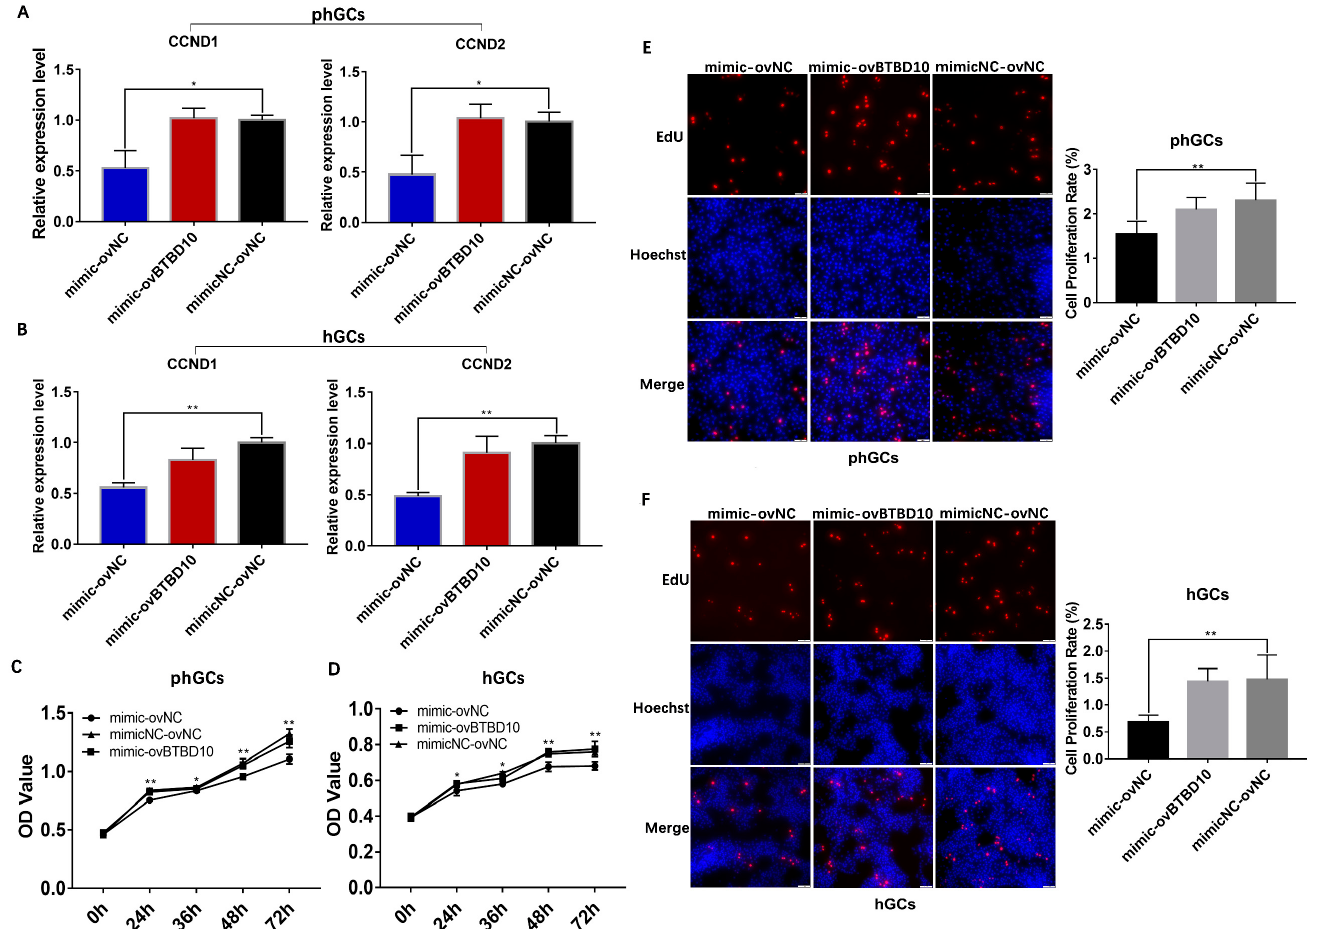
Figure 7. The influence of the co–transfection of miR-202-5p mimic and ovBTBD10 on the proliferation of phGCs and hGCs. The co–transfection of mimic and ovBTBD10 on the expression of CCND1 and CCND2 in phGCs ( A ) and hGCs ( B ) (n = 3). The influence of co–transfection of mimic and ovBTBD10 in cell activity of phGCs ( C ) and hGCs ( D ) detected by CCK8 (n = 6). The EdU staining was conducted to verify the effect of co–transfection on the proliferation rate of phGCs ( E ) and hGCs ( F ) (n = 3). Data are means ± SD of at least technical replicates. * p < 0.05, ** p <